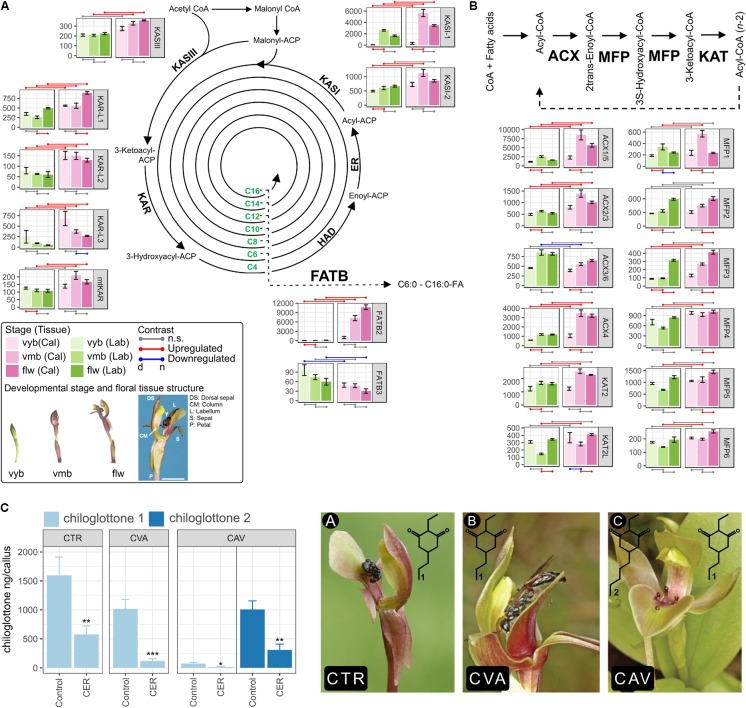
Fatty acid (FA) biosynthesis and degradation pathway gene expression in the callus and labellum tissues of Chiloglottis trapeziformis flowers. Differentially expressed genes of the FA (A) biosynthesis and (B) β-oxidation (degradation) are depicted. Values are normalized transcript counts ± SE. Shades of pink and green colors depict callus and labellum tissues at various flower developmental stage. Developmental stage and floral tissue structure of C. trapeziformis are depicted. The arrow indicates the callus tissue at the flw stage. Scale bar = 7 mm. Red and blue points connecting any two conditions depict statistically significant (FDR < 0.05, |log2FC| > 0.5) upregulation and downregulation, respectively. Gray points depict no significant differential expression. n and d represent the numerator and denominator conditions of each comparisons, respectively. (C) Chiloglottone amounts in the callus of Chiloglottis flowers following incubation with Cerulenin (CER) compared with controls following a 2-h UV-B exposure. Picture A, C. trapeziformis flower; Picture B, C. valida flower; Picture C, C. aff. valida flower. CTR, C. trapeziformis; CVA, C. valida; CAV, C. aff. valida. The number of flowers used in each treatment group are the following: CTRCER = 10, CTRControl = 9, CVACER = 12, CVAControl = 8, CAVCER = 6, CAVControl = 7. Bars represent ± SE. Asterisks indicate significant differences between treatments at ∗P < 0.05, ∗∗P < 0.01, ∗∗∗P < 0.001 based on Student’s t-test. Light and dark blue colors indicate chiloglottone 1 and 2, respectively. All images have been reproduced with permission from the respective copyright holders. Please refer to the Section “Acknowledgments” for image credits.